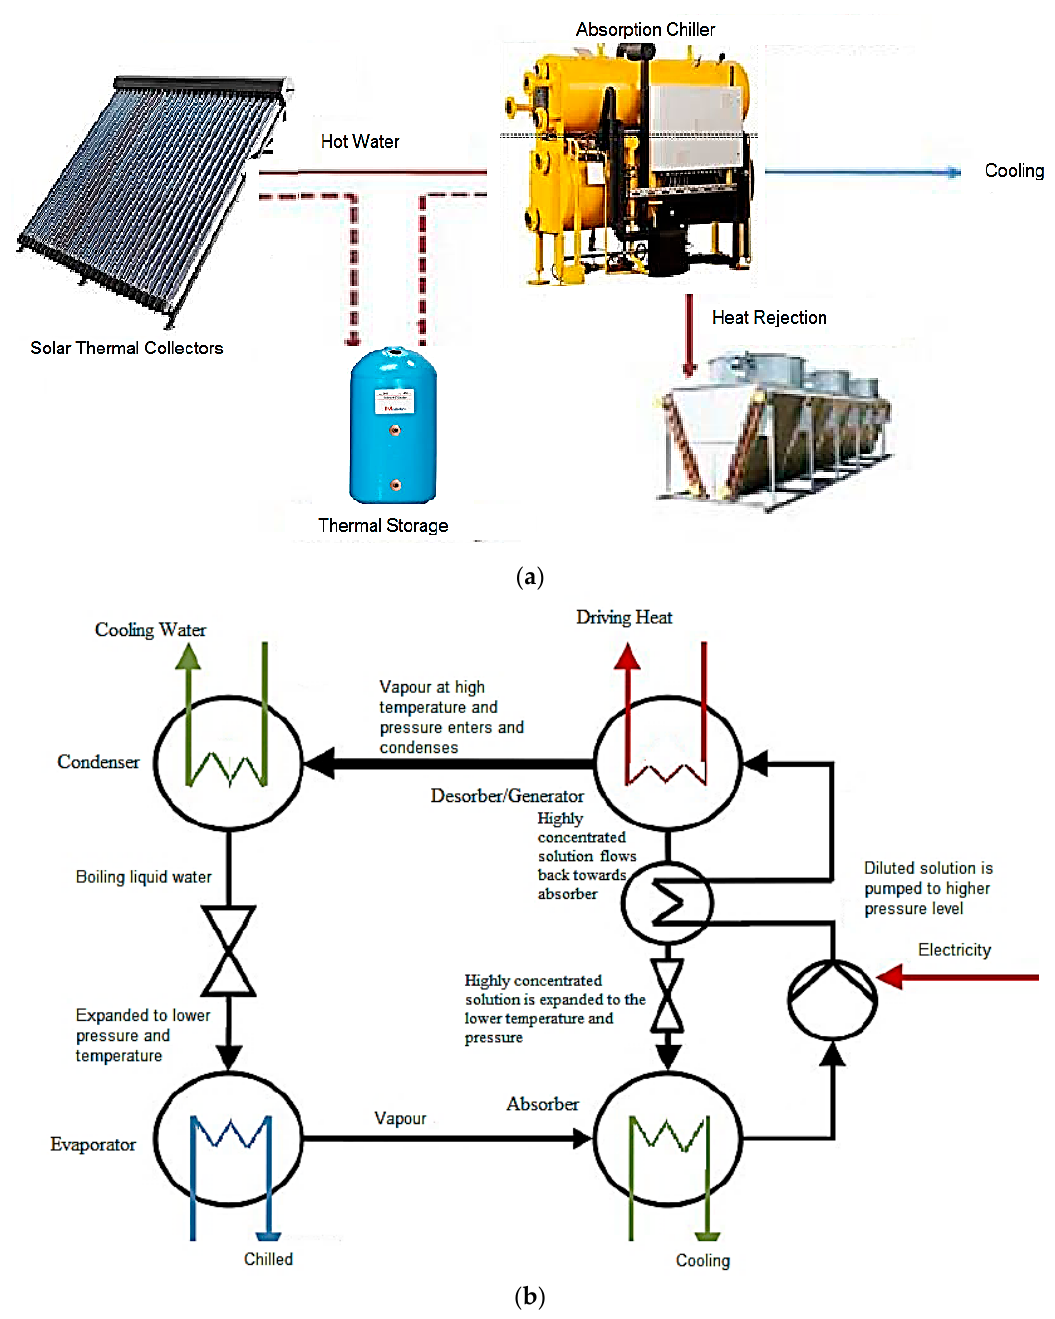
Figure 4. ( a ) Solar thermal cooling system main components and ( b ) absorption chiller cycle.